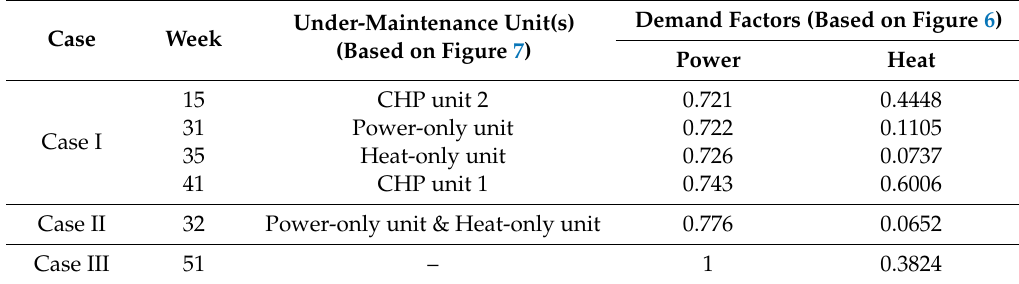
Table 6. Demand factors for the selected weeks.